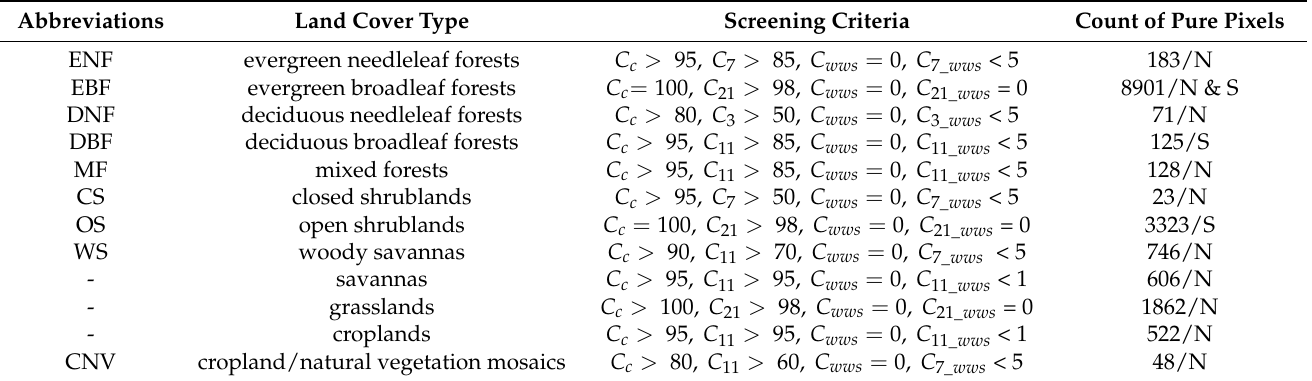
Table 2. The screening criteria and results of pure pixels in MCD12C1 for 12 typical vegetation